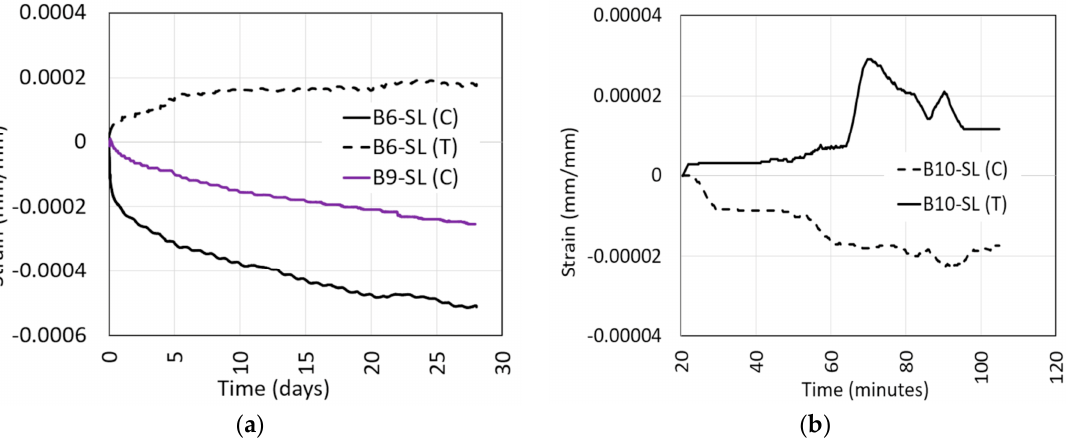
Figure 22. Strain increase with time during the first stage of sustained loading for beams series II. ( a ) Specimens B6-SL and B9-SL ( b ) Specimen